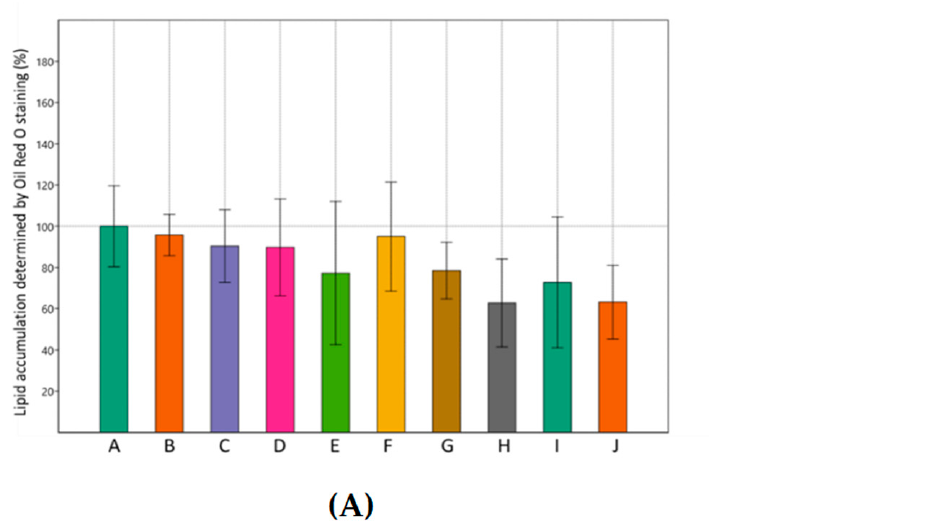
Figure 2. Effects of metformin and simvastatin on lipid accumulation in 3T3-L1 cells. ( A ) The inte- grated density of quantified Oil Red O staining relative to the cell count. A = differentiated cells, B = cells treated with metformin 200 µM, C = cells treated with metformin 2 mM, D = C = cells treated with metformin 4 mM, E = cells treated with simvastatin 100 nM, F = cells treated with simvastatin 1 µM, G = cells treated with simvastatin 2 µM, H = cells treated with the combination of metformin 200 µM and simvastatin 100 nM, I = cells treated with the combination of metformin 2 mM and simvastatin 1 µM, J = cells treated with the combination of metformin 4 mM and simvastatin 2 µM. The data are shown as the means ± SD (standard deviation) from three independent experiments. Data represents a percentage relative to differentiated cells as the control group (One-way ANOVA F(9,27) = 1.04, p = 0.4474 with Tukey HSD post hoc test); ( B ) representative microscopic images presenting lipid droplets formation visualized by Oil Red O staining, captured on the Axioskop 2 MOT micro- scope, 400×, scale 100 µM. Blue = DAPI, cell nuclei; red = Oil Red O, lipid droplets. A = differentiated cells, B = cells treated with the combination of metformin 200 µM and simvastatin 100 nM, C = cells treated with the combination of metformin 2 mM and simvastatin 1 µM, D = cells treated with the combination of metformin 4 mM and simvastatin 2 µM. 2.2. Effects of Metformin and Simvastatin on Expression of Adipogenic Genes We examined whether MET and SIM affected the mRNA levels of adipogenic tran- scription factors PPAR γ , C/EBP α , and SREBP-1C during adipocyte differentiation. Figure 3 shows the effect of sustained MET and SIM exposure for nine days on the gene expres- sion levels. Compared to differentiated cells, significant down-regulation of C/EBP α and SREBP-1C was observed upon treatment with the highest concentration of combined MET-SIM treatment (4 mM + 2 µM), but also when treating cells only with SIM in higher concentration (1 µM and 2 µM) (Figure 3B,C). The same effect was observed on PPAR γ mRNA levels, only not statistically significant. On the other hand, the lowest concentra- tion of SIM (100 nM) and combined MET-SIM treatment (100 nM + 200 µM) had similar effects on all examined transcription factors, where the mRNA levels were equal or even slightly increased compared to differentiated cells (Figure 3).